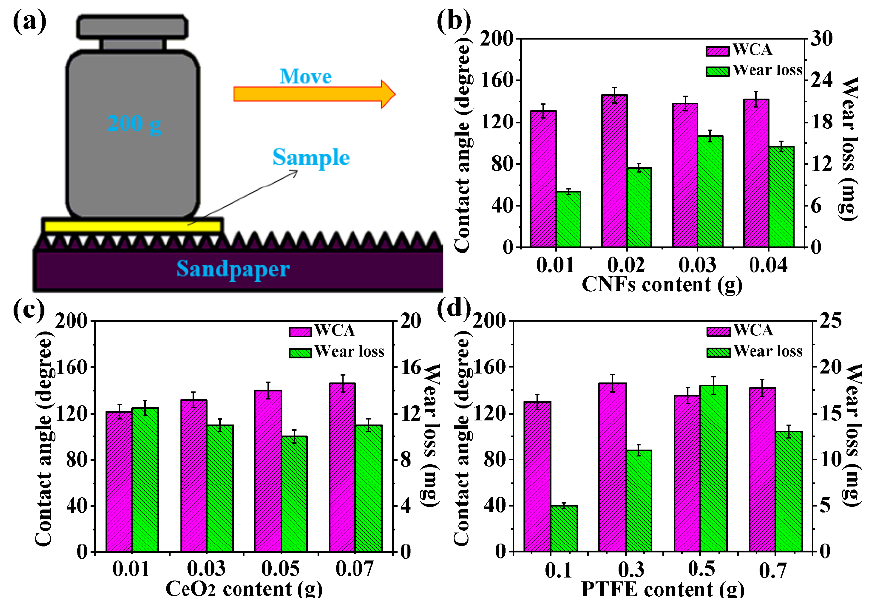
Figure 9. ( a ) Schematic illustration of the abrasion test. Variations in the WCA and wear loss of the CSC-coating at different ( b ) CNFs, ( c ) CeO 2 , and ( d ) PTFE contents after abrasion. The corresponding abrasion morphologies are exhibited in Figures 10 and 11. In Figure 10a, after the abrasion, obvious scaly abrasion marks were found on the surface. In Figure 10b,c, the abrasion on the coating surface became worse with increasing CNF content. Meanwhile, the abrasive surface began to exhibit protruding granular wear marks. However, at 0.04 g CNFs, partial abscission could be clearly seen on the coating surface in Figure 10d. The above phenomena may be explained by the fact that increasing the carbon nanofiber content can reduce the cohesion within the